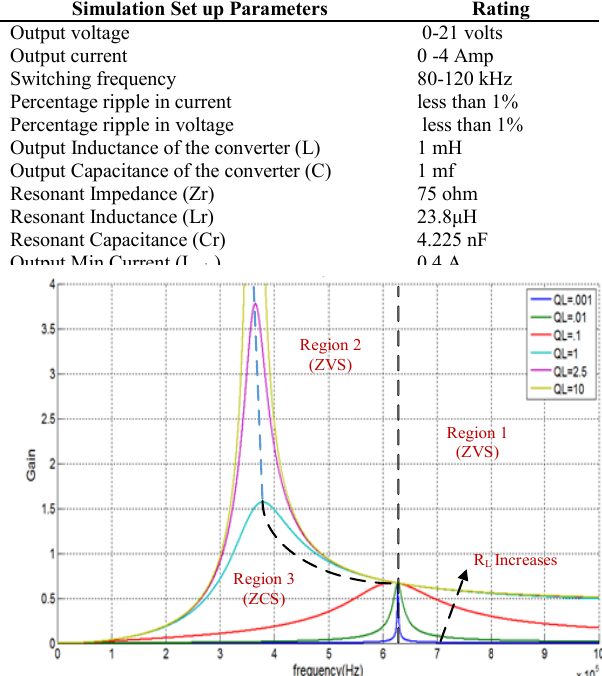
Fig. 4 Frequency response of output voltage gain of the LLC resonant converter